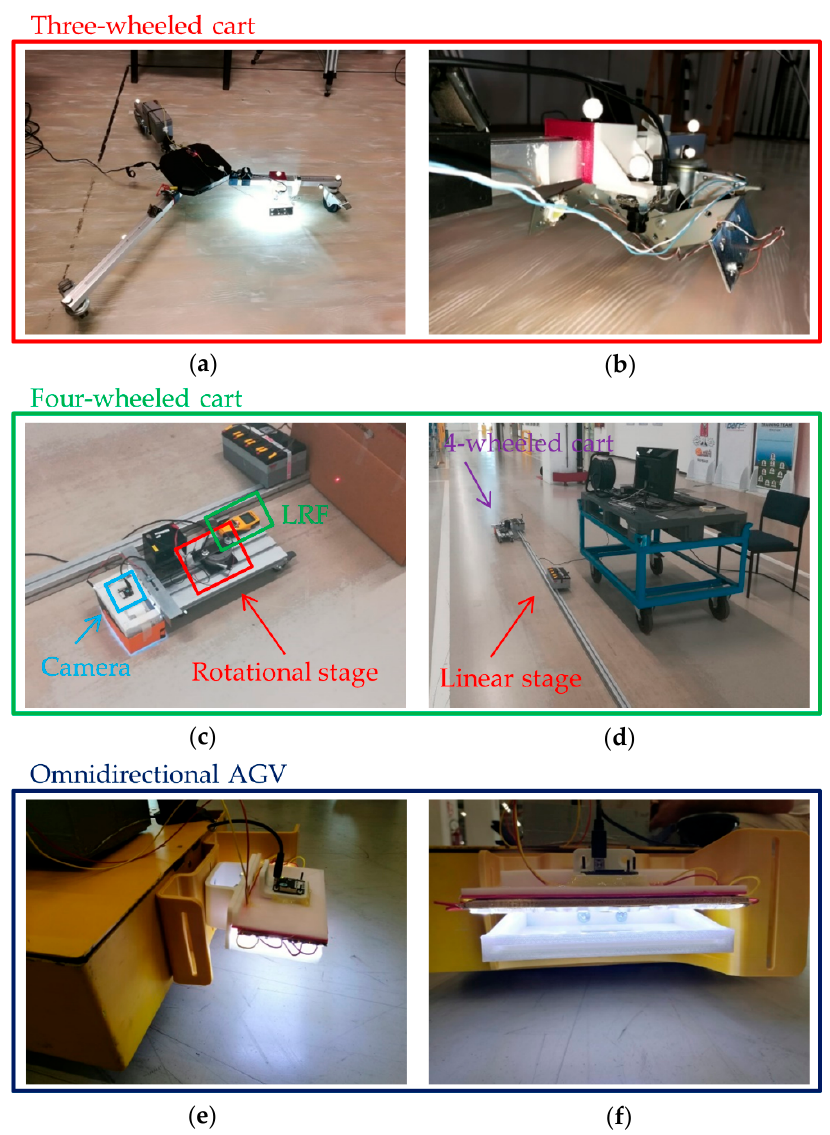
Figure 9. ( a ) Top view of the experimental three-axle cart and ( b ) side view of the lighting system together with the monocular camera and the spherical Vicon markers. ( c ) Four-wheeled cart, rotational stage and Laser Range Finder (LRF) for obtaining the ground truth and ( d ) global setup including the linear stage used with the four-wheeled cart. ( e ) side view of the vision-based odometer fastened onto the omnidirectional AGV and ( f ) front view of the lighting system together with the monocular camera.